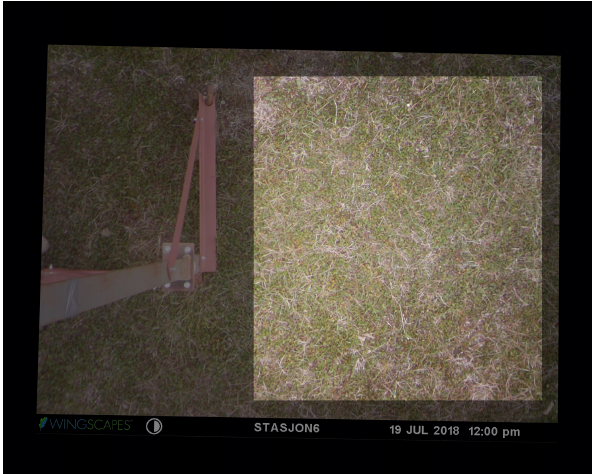
Figure 3. Example of a stabilized photo for rack 6, taken on 19 July 2018 at noon CEST. Slight movements by the thawing of the topsoil turned this camera a few angles out of its original position, which was corrected for by the stabilization algorithm through a rotation of the photo. The bright rectangle indicates the mask for which the greenness index was calculated, which excludes parts of the photo where the rack itself is visible as well as areas where shadows were cast by the rack (darkened regions). The ground surface defined by these masks has been verified to be visible in all